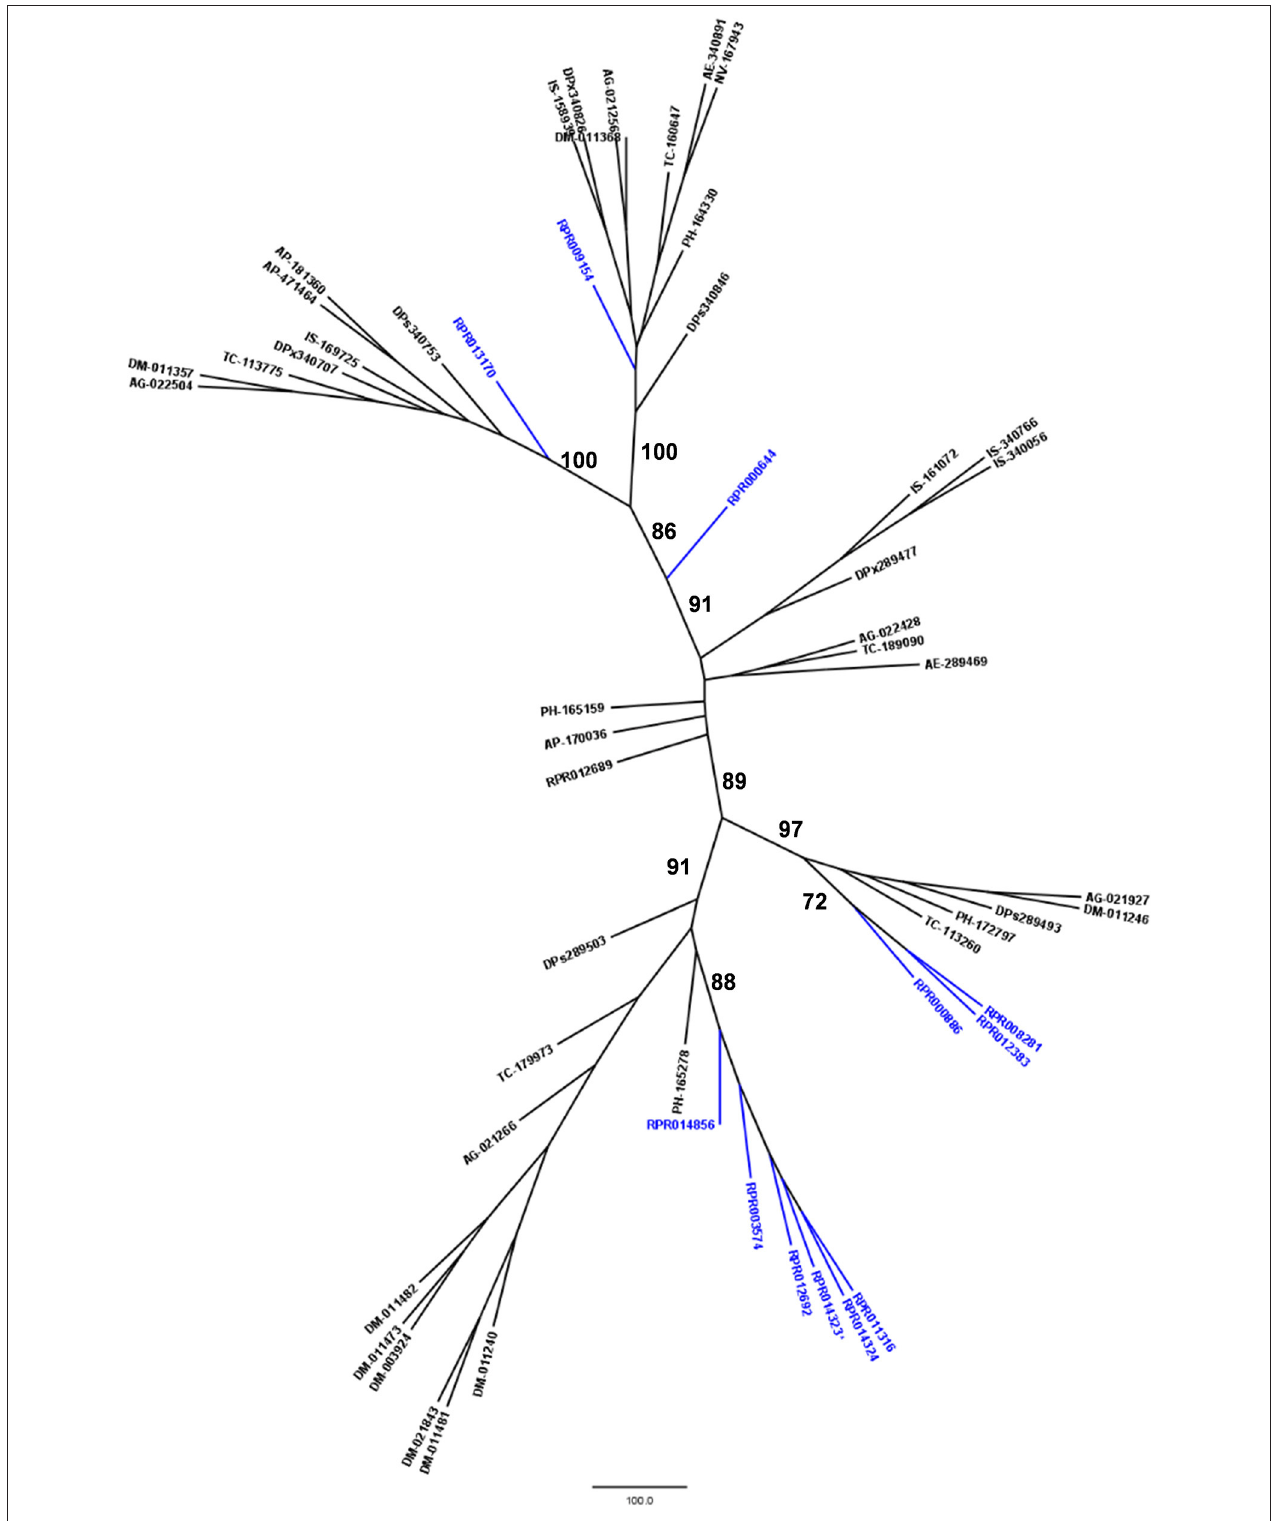
FIGURE 6 | Phylogenetic tree of amino acid sequences from peptidase family M17 (Leucine Aminopeptidases) common in insect genomes which contain high gene copy numbers in the Rhodnius prolixus genome. Trees gather sequences from 19 arthropod species. Blue, branches with R. prolixus peptidases; Black, branches